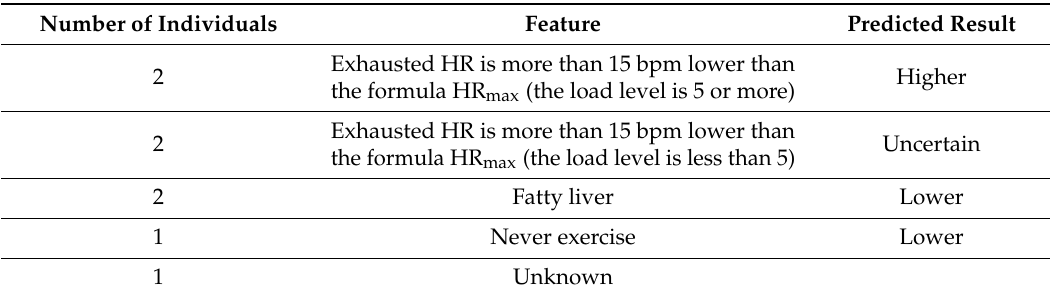
Exhausted HR is more than 15 bpm lower than Uncertain the formula HR max (the load level is less than 5) Fatty liver Lower Never exercise